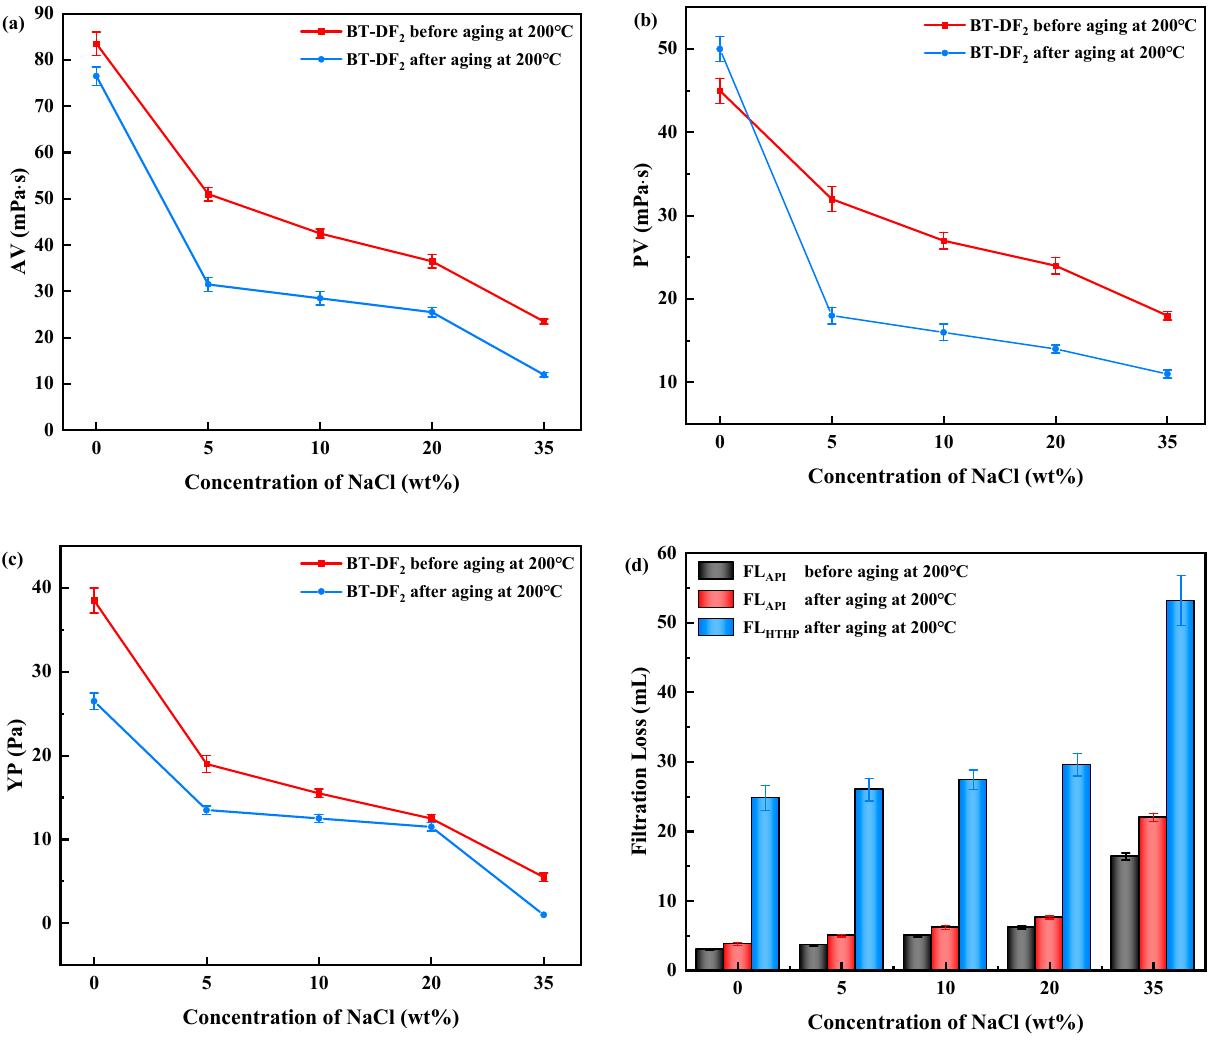
Figure 5. The performance of BT-DF2 under different NaCl concentrations: ( a – c ) Rheological parameters of BT-DF2 under different concentrations of NaCl; ( d ) Filtration loss of BT-DF2 under different concentrations of NaCl.